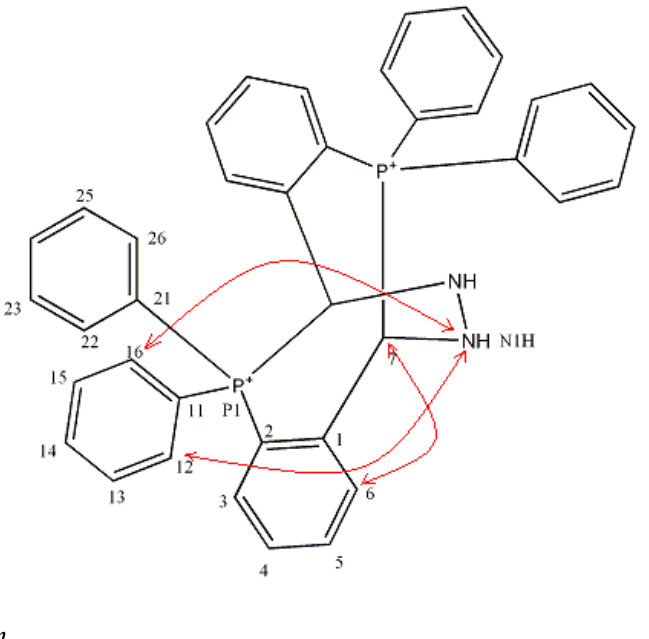
Figure 2. Important correlations obtained from NOESY